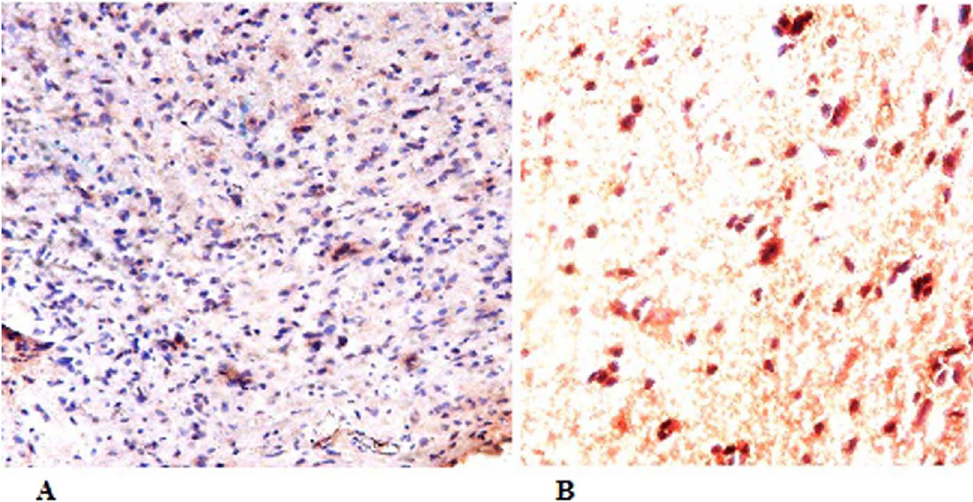
Figure 1. Protein expression of MGMT by Immunohistochemistry (IHC). ( A ): MGMT showing complete expression of the protein in tumor cell with unmethylated DNA. ( B ): Lack of MGMT protein expression with its Methylated MGMT promoter in the majority of tumor